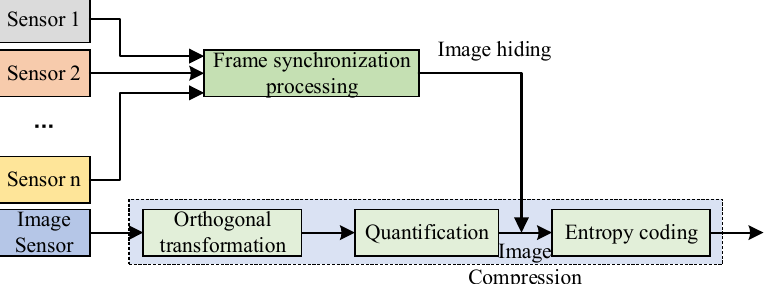
Figure 2. Multichannel image information hybrid transmission scheme.